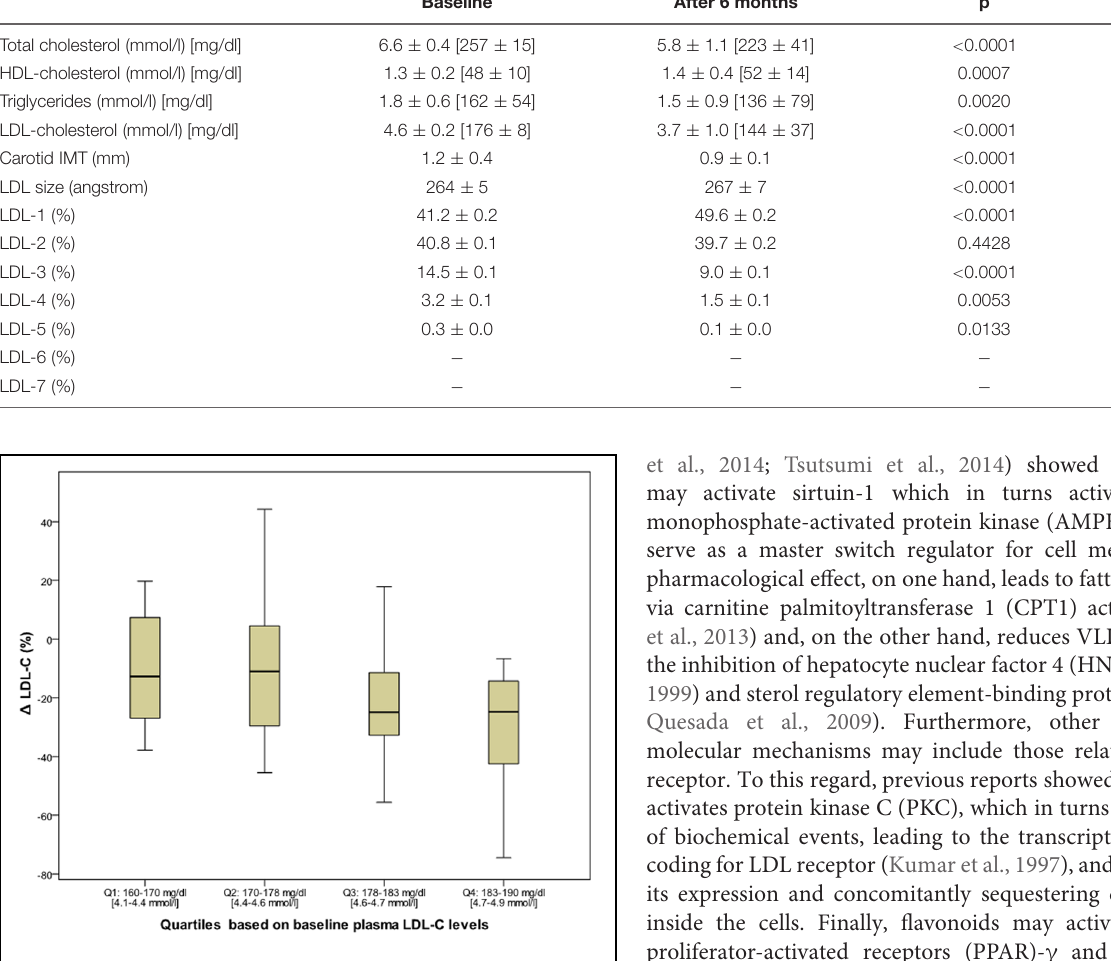
TABLE 2 | Effects of Bergavit R (cid:2) (150 mg of flavonoids, with 16% of neoeriocitrin, 47% of neohesperidin, and 37% of naringin, daily) on plasma lipids, LDL subclasses and carotid intima-media thickness (IMT) in subjects with moderate hypercholesterolemia after 6 months of supplementation. Baseline After 6 months